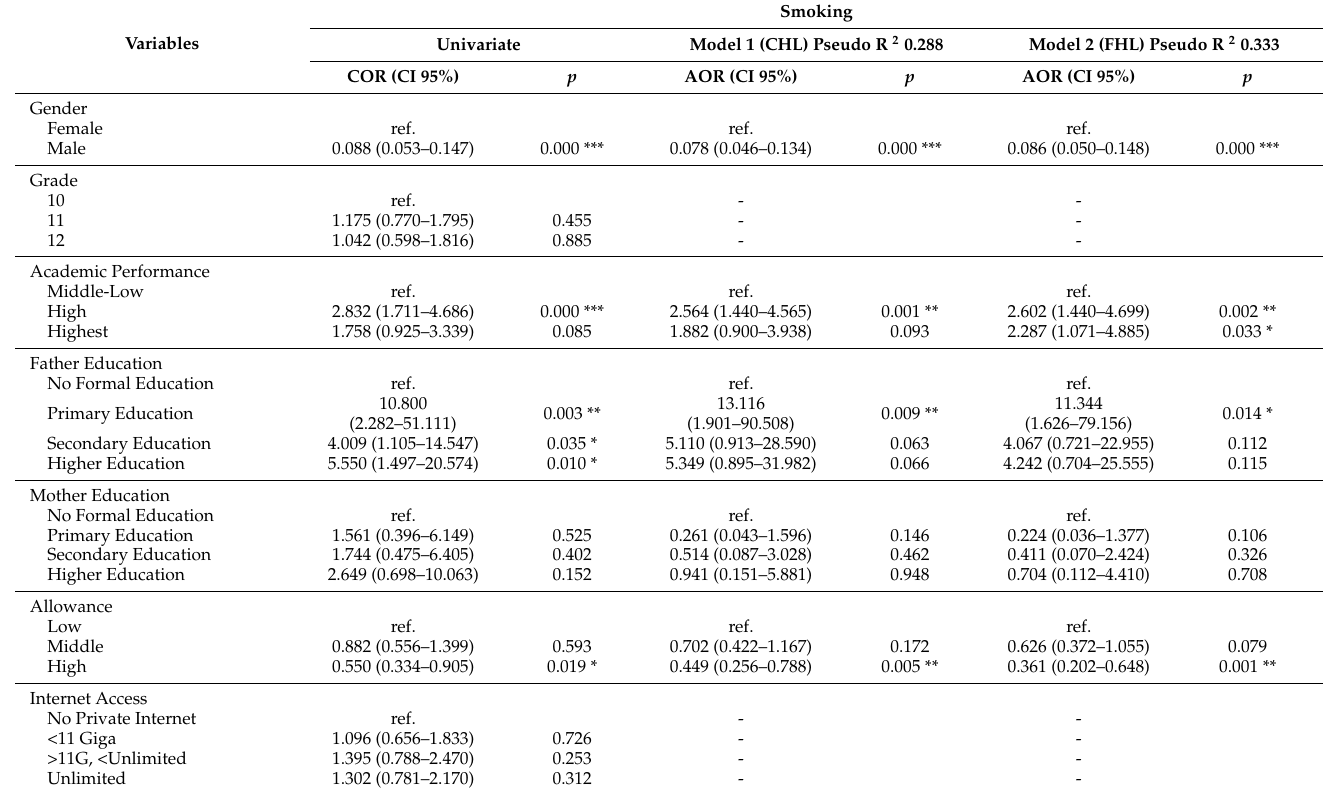
Table 6. Univariate and multivariate logistic regression of smoking with socioeconomic factors in the CHL and FHL